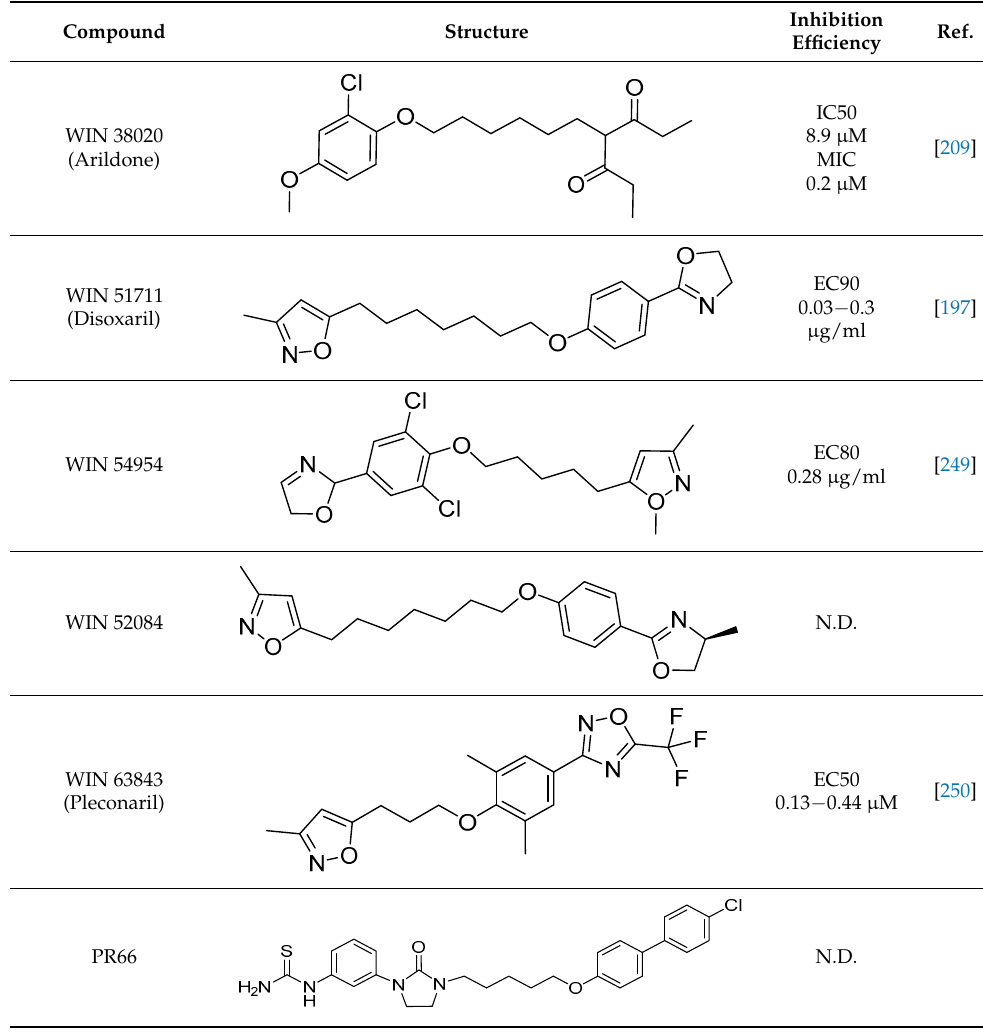
Table 5. List of compounds targeting capsid protein or capsid of picornaviruses.